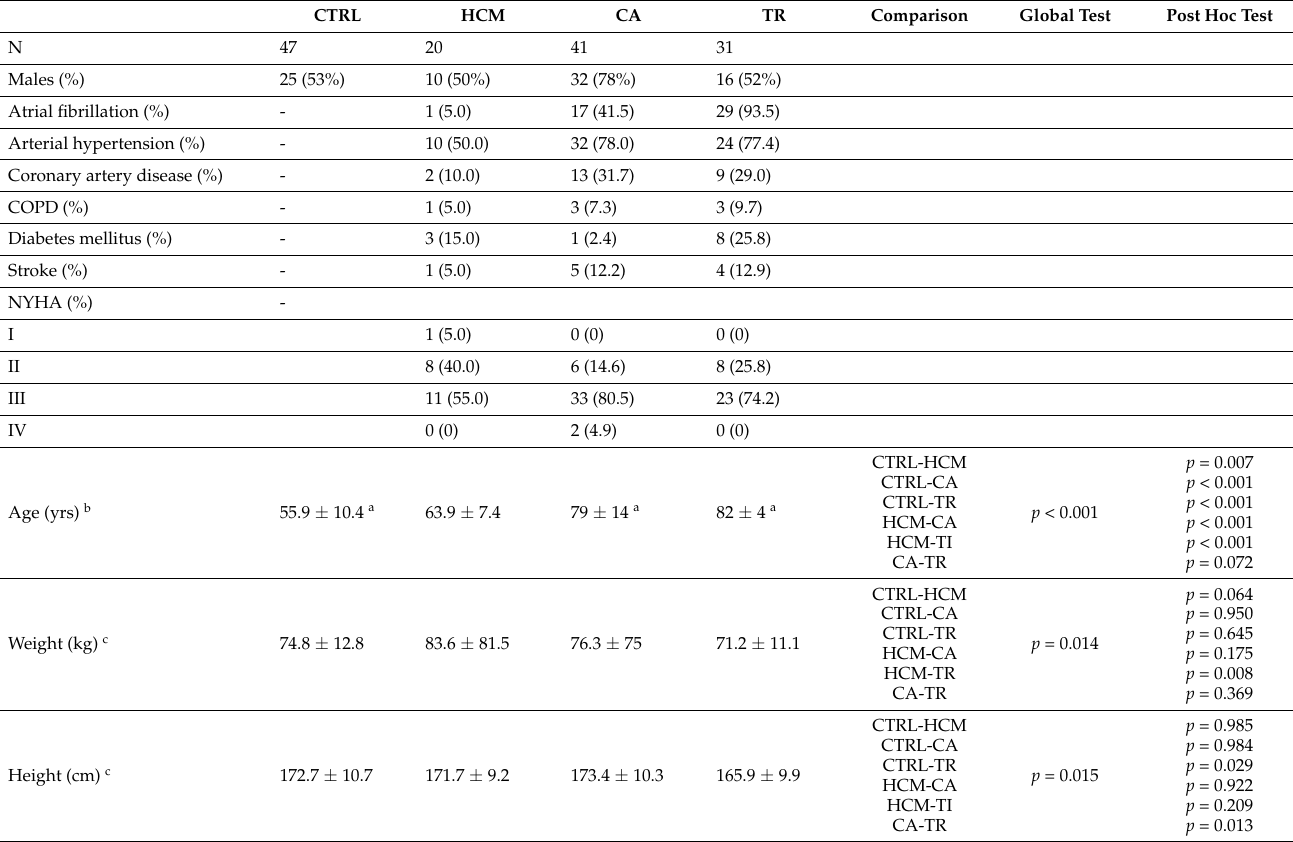
Table 1. Baseline parameters of HCM, CA, TR and CTRL